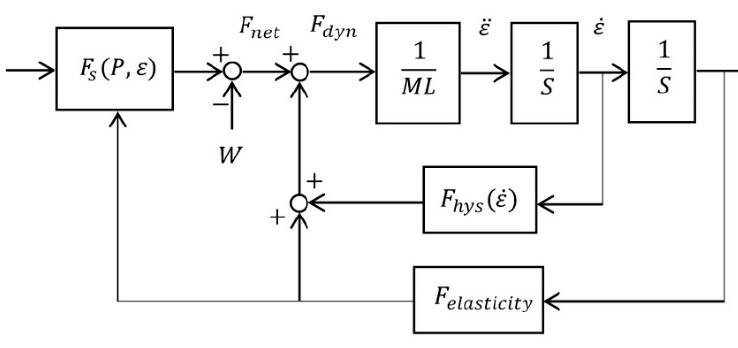
Figure 4. Block diagram of empirical modeling. Table 2. Model